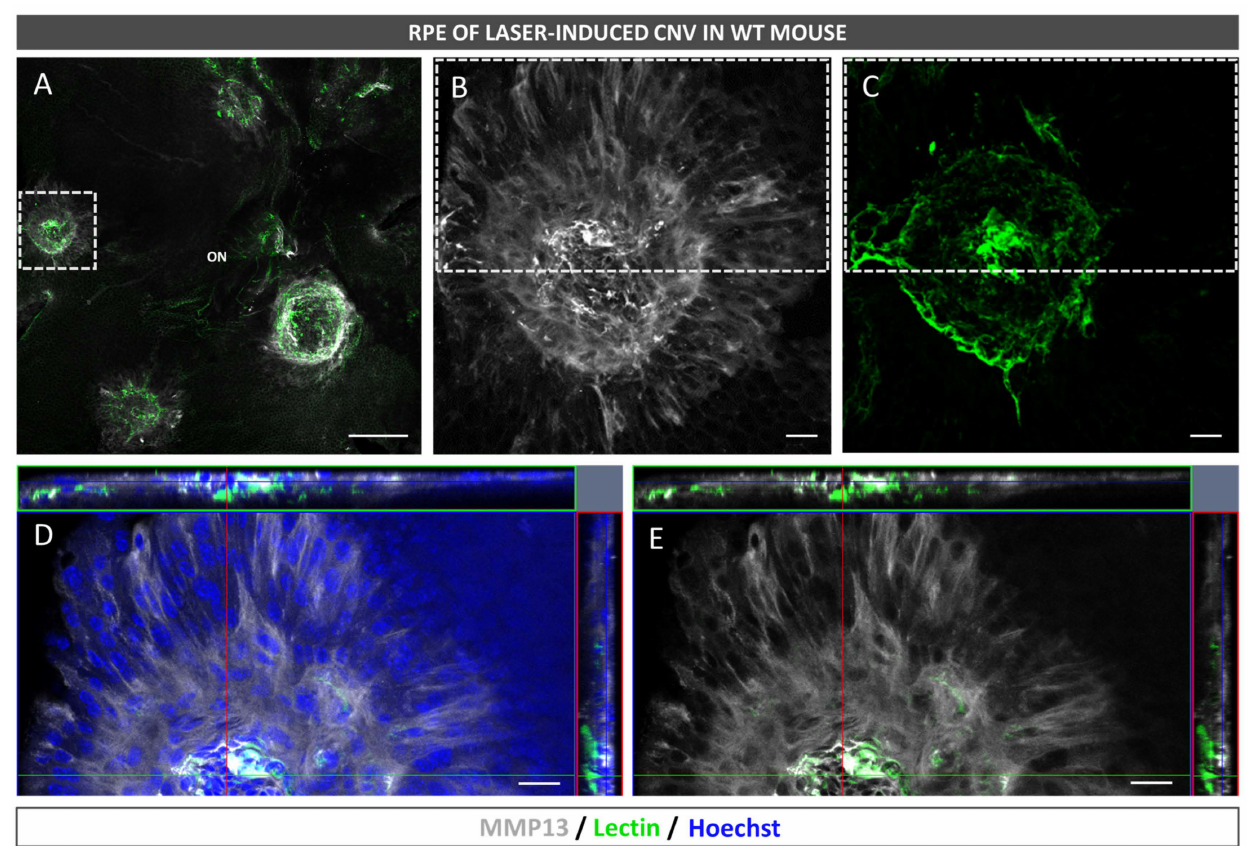
Figure 6. MMP13 is overexpressed in the RPE underlying the CNV. Representative laser-induced CNV lesions on choroidal flatmounts from WT mice stained with MMP13 (white), lectin (green), and Hoechst 33342 (blue). RPE cells underlying the laser-induced CNV mice were positive for MMP13 staining, while the RPE far from this area did not express MMP13. ( A ) Whole flatmount micrograph with three successfully laser-induced CNV lesions; the outlined region represents the magnification in ( B , C ). ( B ) MMP13 staining in the CNV area. ( C ) Lectin staining in the CNV area. The outlined region represents the magnification in ( D , E ). Panels ( D , E ) show that lectin-negative cells, corresponding to RPE cells, expressed MMP13 close to the area of CNV but not outside the lesion. n = 8. Hoechst 33342, blue; lectin, green; and MMP13, white. CNV = choroidal neovascularization. MMP13 = matrix metalloproteinase 13. ON = optic nerve. RPE = retinal pigment epithelium. Scale bars: 200 µ m ( A ), 20 µ m ( B – E